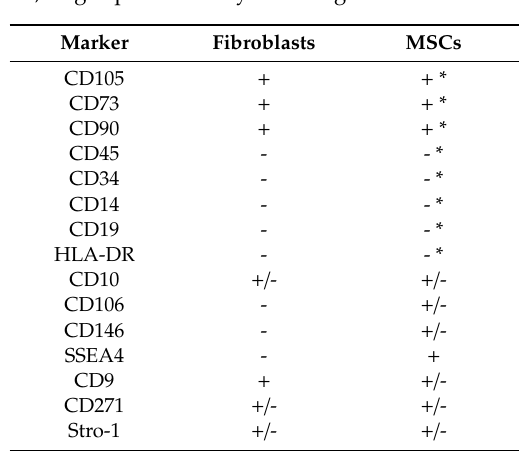
Table 1. Phenotypes of fibroblasts and mesenchymal stromal cells (MSCs). * phenotypes required to be identified as MSCs according to the proposal by The International Society for Cellular Therapy 2006 [12]. + positive; - negative; SSEA, stage-specific embryonic antigen.